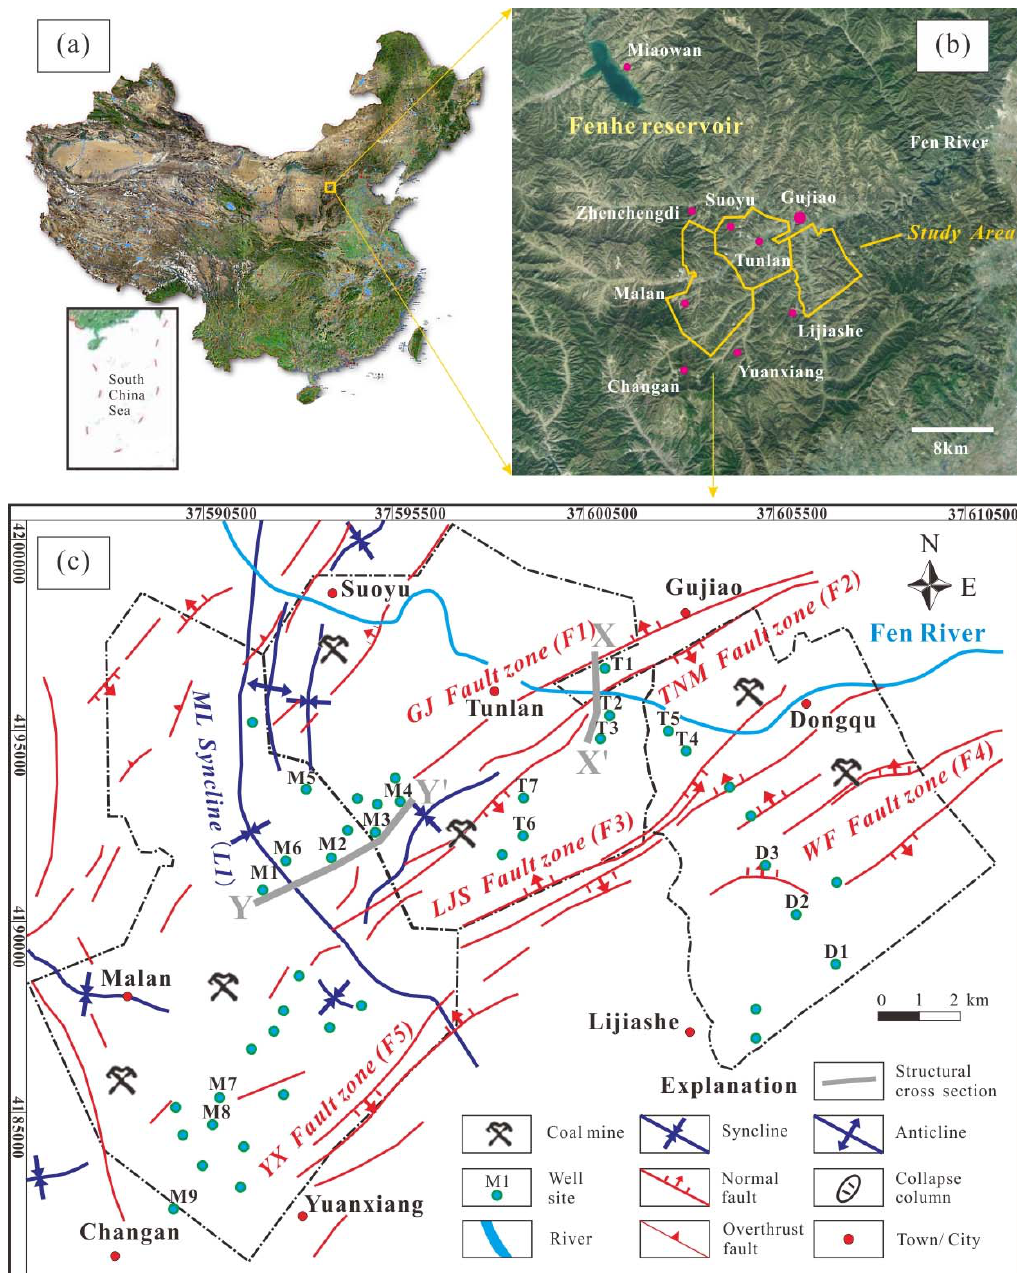
Figure 1. Location of the Gujiao area in the northern Qinshui basin, North China. ( a ) The general position of the Gujiao area in China. ( b ) Topography and river system of research area and its adjacent areas. ( c ) Geological structures, river systems, and well sites are distributed in the Gujiao area and along section lines X–X’ and Y–Y’.